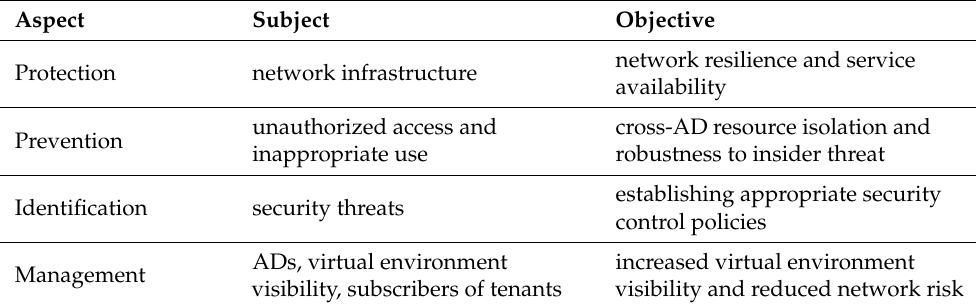
Table 1. Identified challenges in network slicing